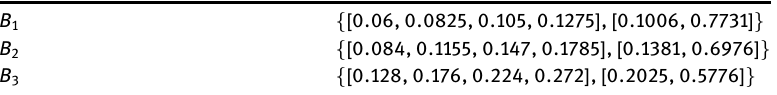
Table 8: Utilize the ITFHA Operator. B